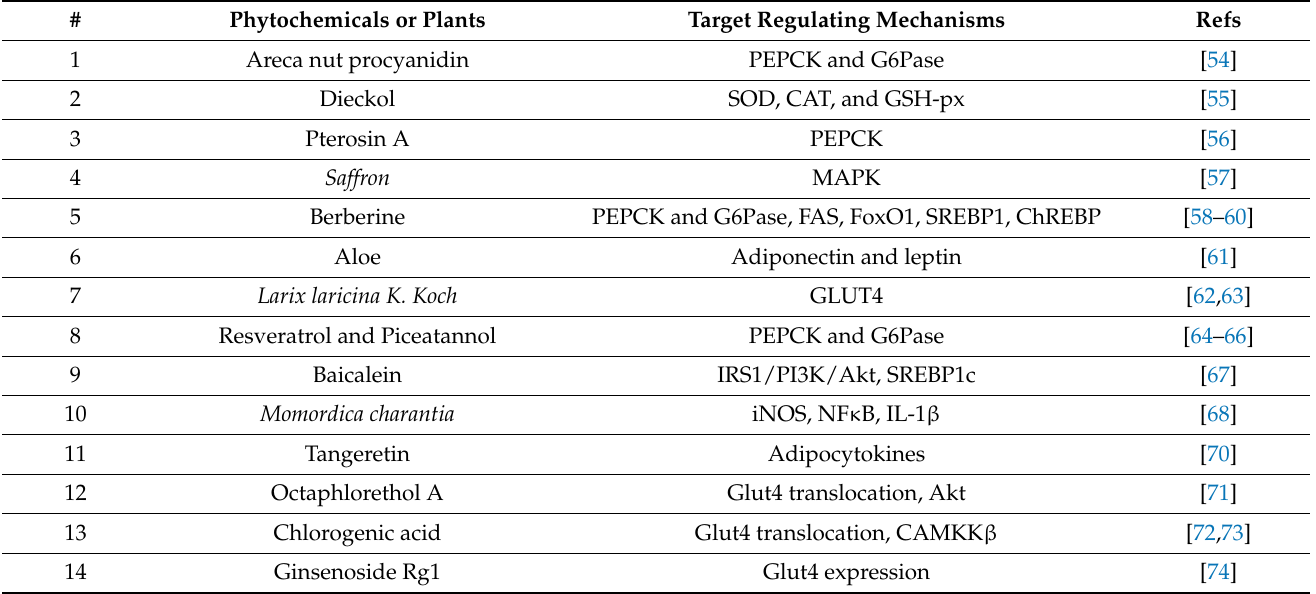
Table 1. Phytochemicals or plants and their target mechanism via AMPK activation in diabetes